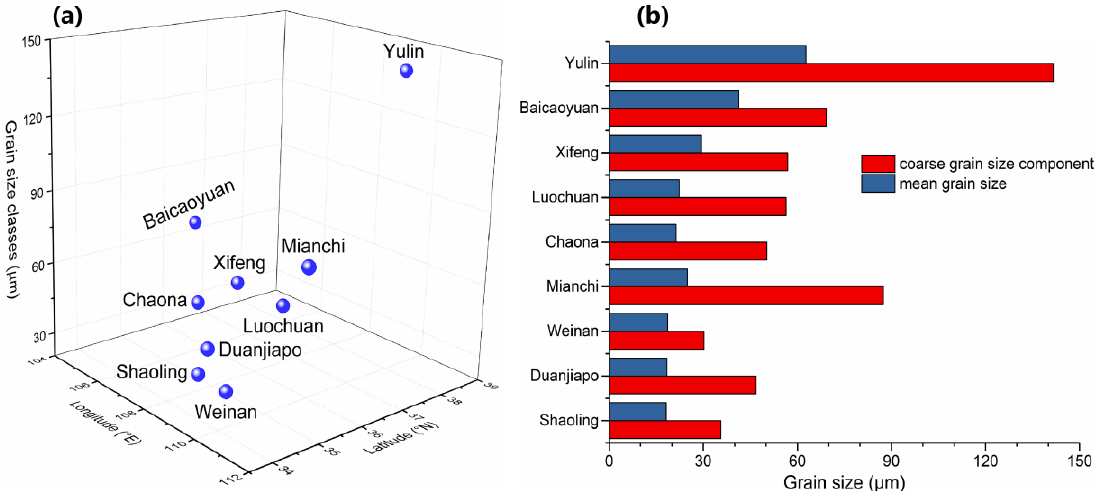
Figure 3. Variations in coarse particle size by scatter plot ( a ) and bar graph ( b ) from nine last glacial loess sections.